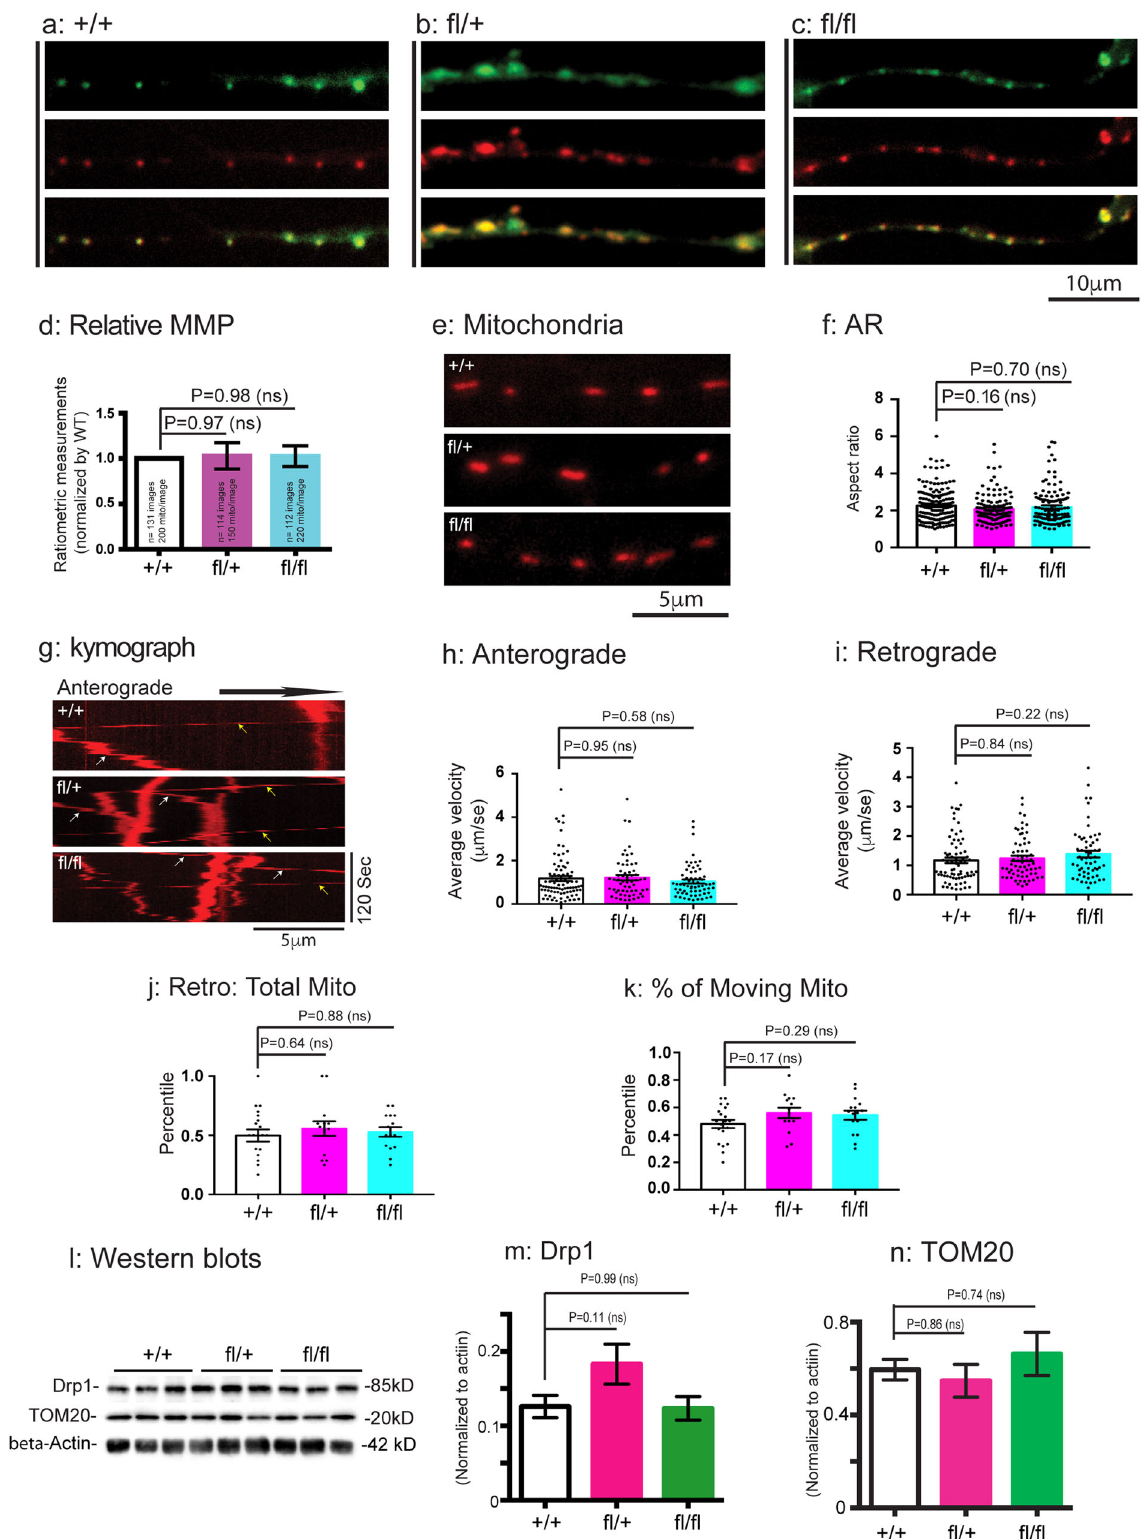
Human fi broblasts from healthy control and CMT2B Rab7 V162M patient . Human fi broblasts were isolated from skin of patients affected by CMT2B (two 46 and 53-year old men and 52-year-old woman) and from healthy control individuals age and sex matched 33,47 . These CMT2B patients are from the fi rst identi fi ed Italian family affected by this pathology, which was diagnosed at Azienda Ospedaliera Universitaria “ Federico II ” of Naples. Clinical history and